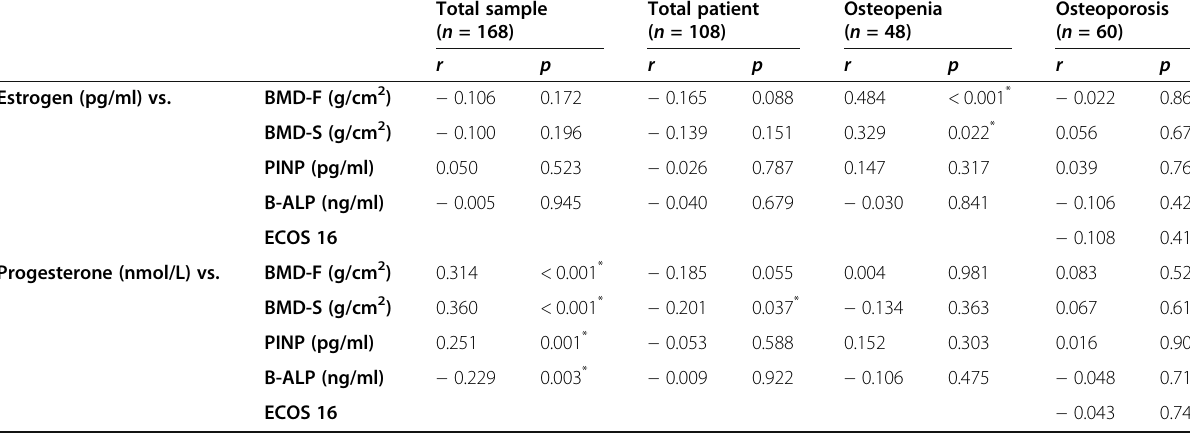
Total sample ( n = 168)